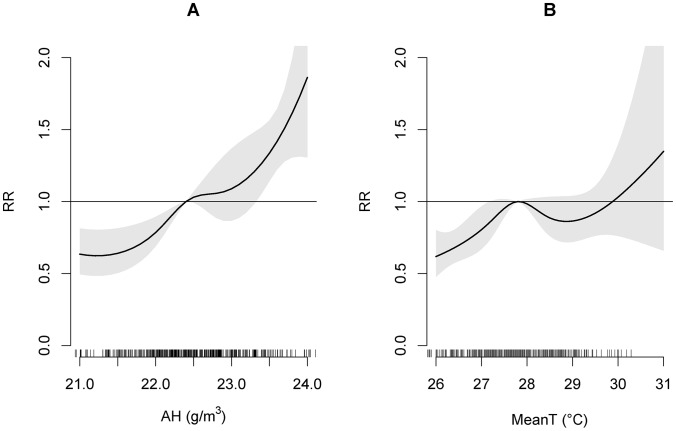
Effect of AH and MeanT on relative risk (RR) of dengue incidence.A: RR curve shows overall cumulative effect of AH (with the maximum lag number up to 16 weeks) on dengue incidence with reference value of AH being 22.4 g/m3 and 95% CI of fitted RR shown in the grey region; B: RR curve shows overall cumulative effect of MeanT (with the maximum lag number up to 9 weeks) on dengue incidence with reference value of MeanT being 27.8°C and 95% CI of fitted RR shown in the grey region.